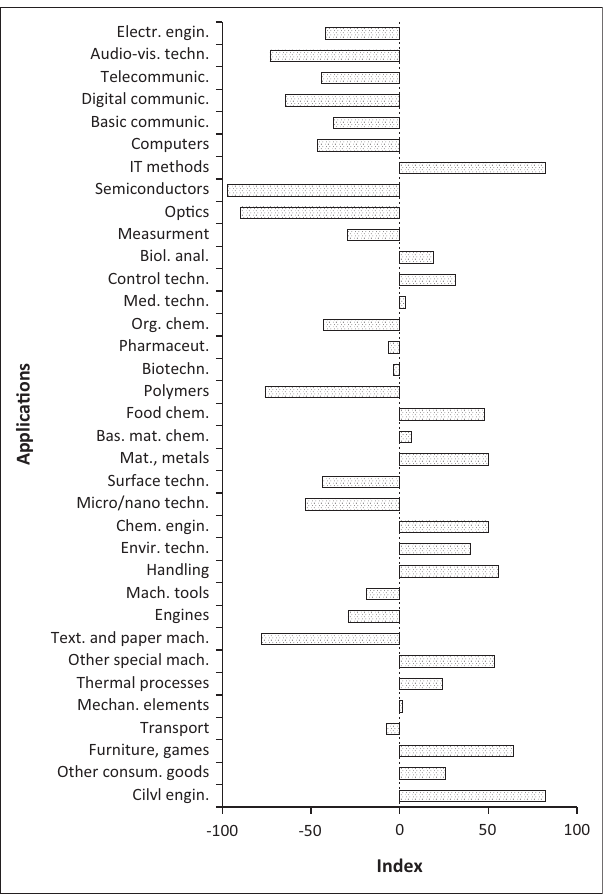
FIGURE 3 : Specialisation profile of South African PCT applications, 2010–2018 (Reference: Worldwide transnational